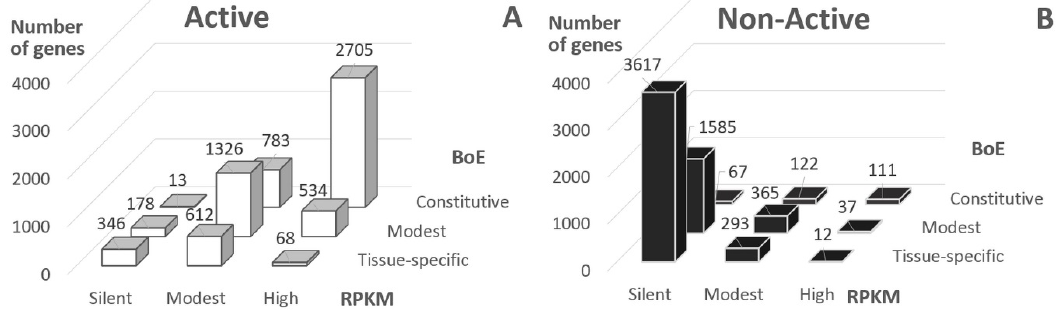
Figure 1. Classification of genes according to expression level (RPKM, reads per kilobase million) and breadth of expression (BoE). BoE was computed for 29 tissues; RPKM values respected to S2 cells; panels ( A ) and ( B ) show “Active” and “Non-Active” genes, these classes respect to Aquamarine and Lazurite/Malachite/Ruby chromatin states according to 4HMM [23,30] (see Section 4).